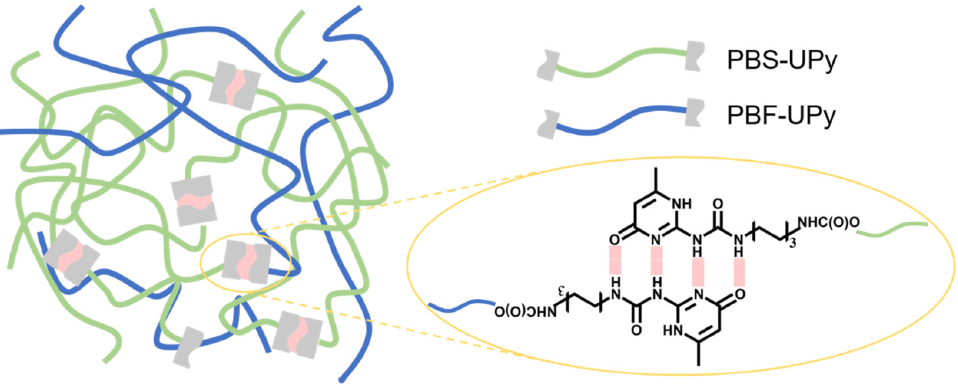
Figure 10. Schematic illustration of the formation of supramolecular polymer in the blends of PBS ‐ UPy and PBF ‐ UPy.